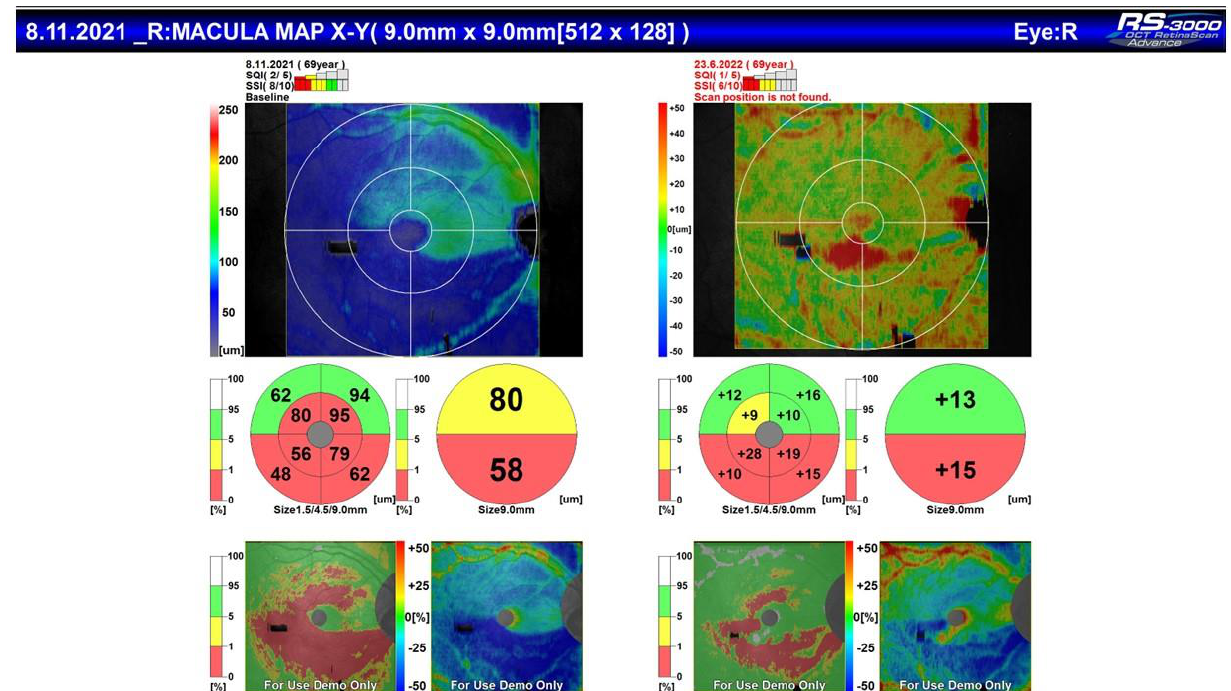
Figure 8. Visual field after the surgical procedure.